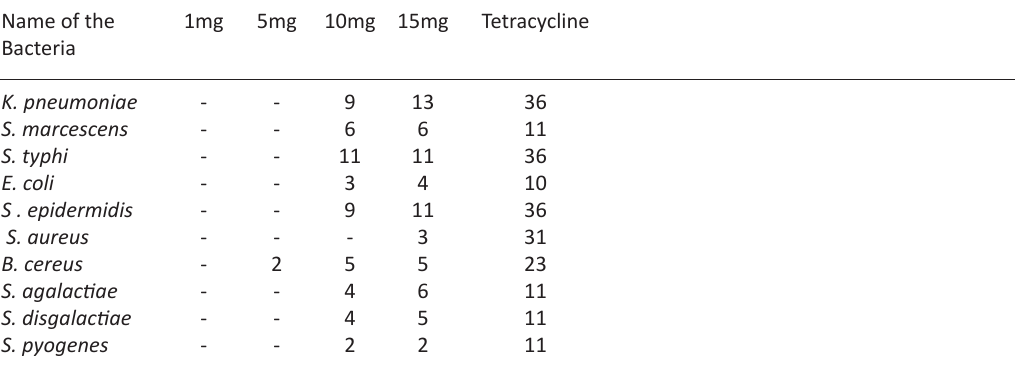
Table 3. Antibacterial activity using A. indica extract with ethyl acetate against bacterial pathogens Name of